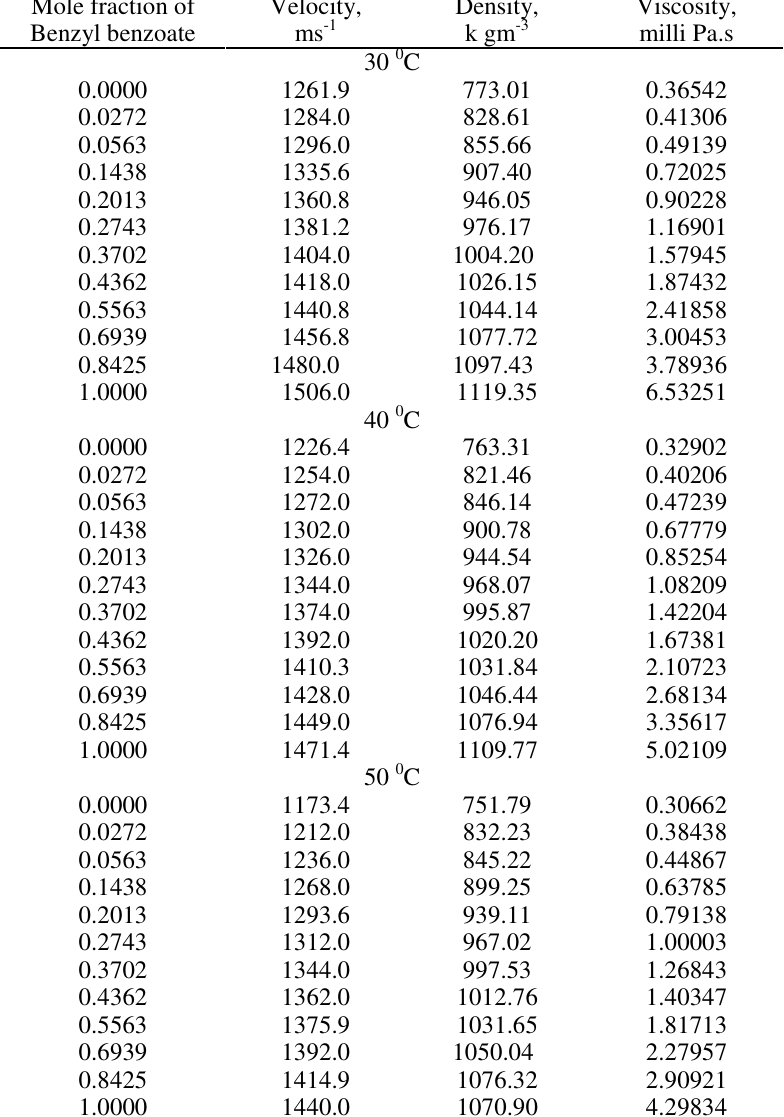
Table 1. Ultrasonic velocities, densities and viscosities for the system benzyl benzoate